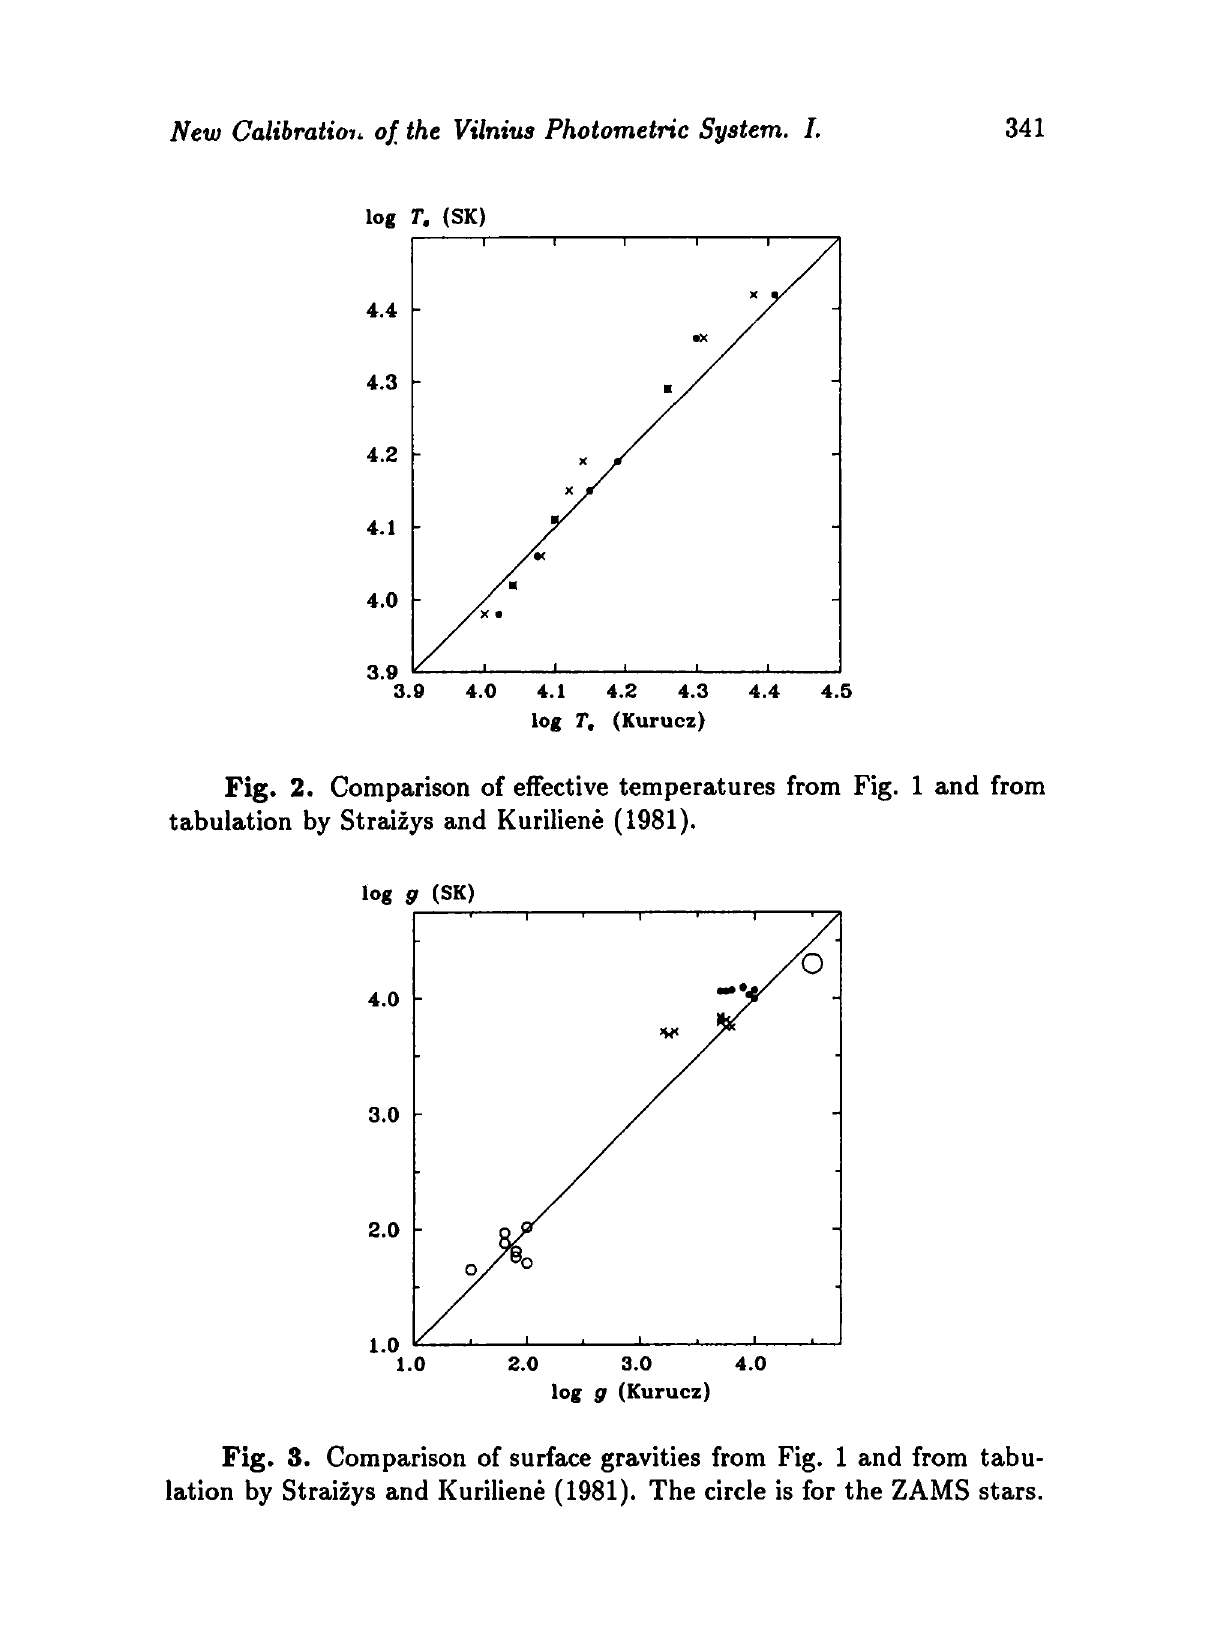
Fig. 3. Comparison of surface gravities from Fig. 1 and from tabu- lation by Straizys and Kuriliene (1981). The circle is for the ZAMS